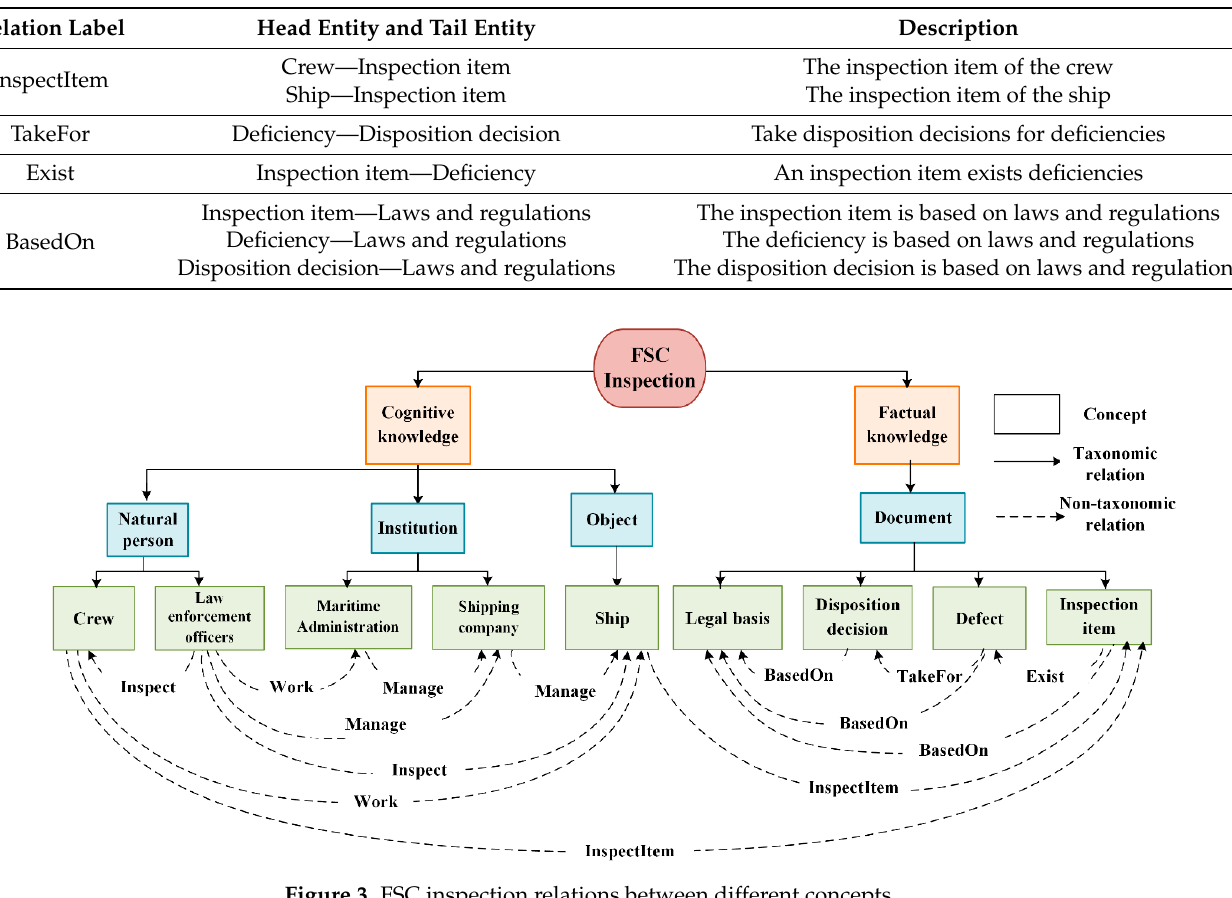
Figure 3. FSC inspection relations between different concepts. Table 2. Relations in the constructed knowledge graph.